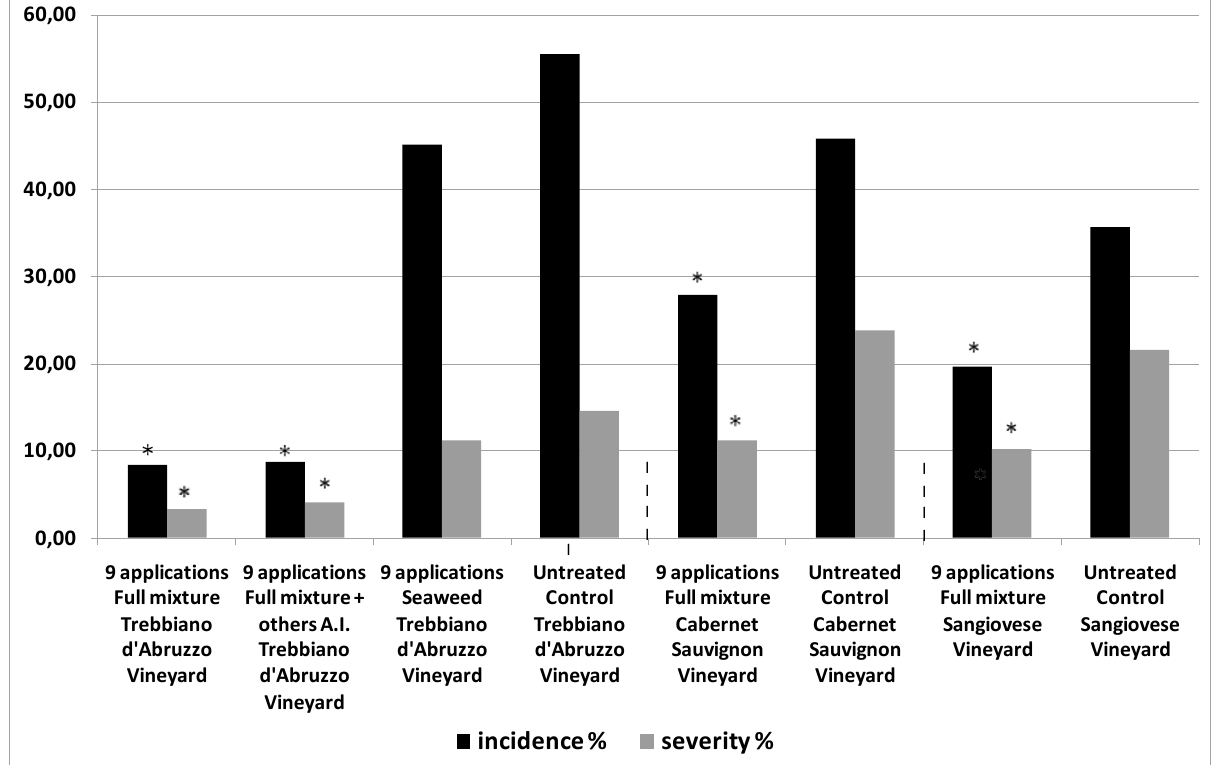
Figure 3. Mean incidence and severity of GLSD leaf symptoms in Trebbiano d’Abruzzo, Cabernet Sauvignon and San- giovese vineyards after applications of the mixture of CaCL 2 , Mg(NO 3 ) 2 or seaweed extract in 2015. Chi-square statistics compared the full mixture treatments to the untreated controls in three trials. In the Trebbiano d’Abruzzo vineyard, the full mixture, alone or in tank mix with active ingredients used for control of other diseases or pests, or seaweed alone treatments, were compared to the untreated control. For symptom incidence or severity, * indicates statistically significant differences ( P < 0.05) between each treatment and the untreated